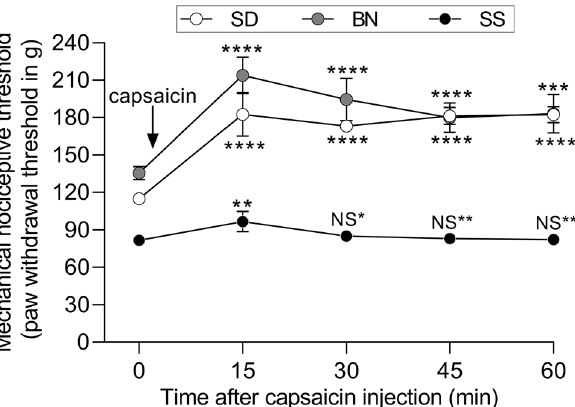
Figure 6. DNIC is impaired in SS rats. The baseline hindpaw withdrawal threshold in SS, SD, and BN rats was determined by the Randall-Selitto test. In sequence, a subdermal injection of capsaicin (125 µg, 50 µl) was performed into the right forepaw, followed by evaluation of the hindpaw withdrawal thresholds at 15 min intervals. While the hindpaw withdrawal threshold markedly increased in the SD (F (1.825, 20.08) = 53.23, **** p < 0.0001, when the paw-withdrawal thresholds were compared to baseline, pre-capsaicin, thresholds, one-way repeated measures ANOVA followed by Bonferroni posttest) and BN (F (3.139, 28.25) = 32.20, **** p < 0.0001 and *** p = 0.0002) rats, compatible with the presence of DNIC, in the SS group, no significant change in the nociceptive threshold was observed